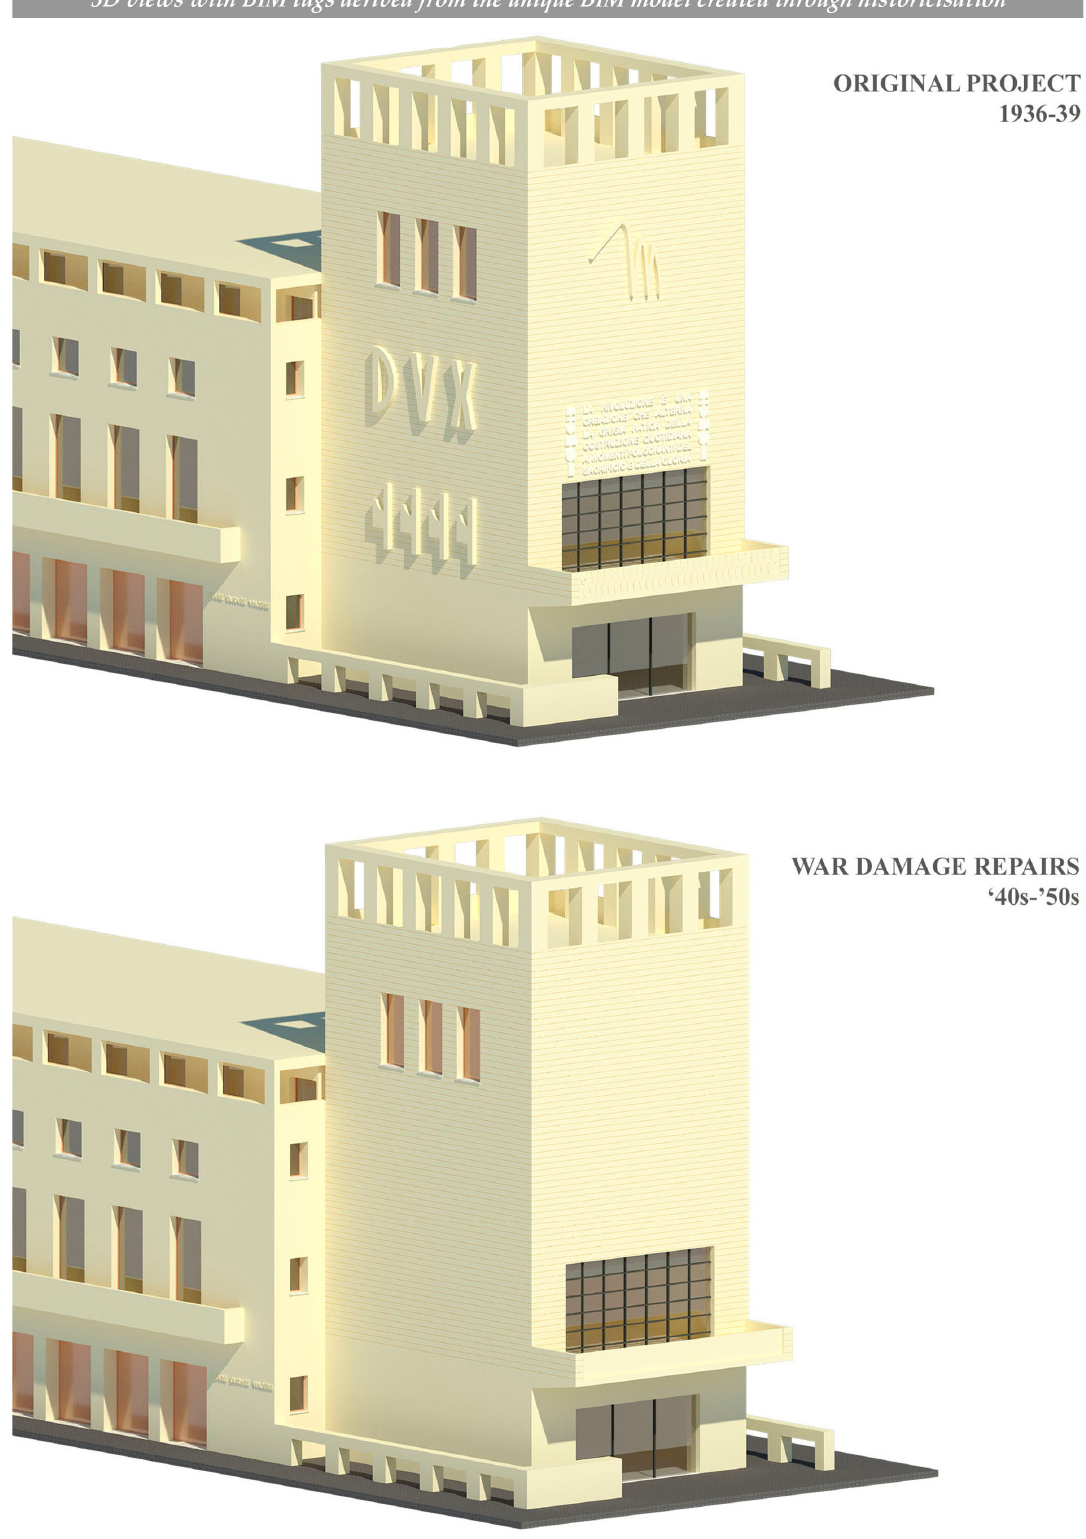
Figure 17. The model historicisation to document the variation of venustas of the former Fascist House. The removal of fascist symbols from the tower façades during war damage repairs (cf. Figure 6 for historical